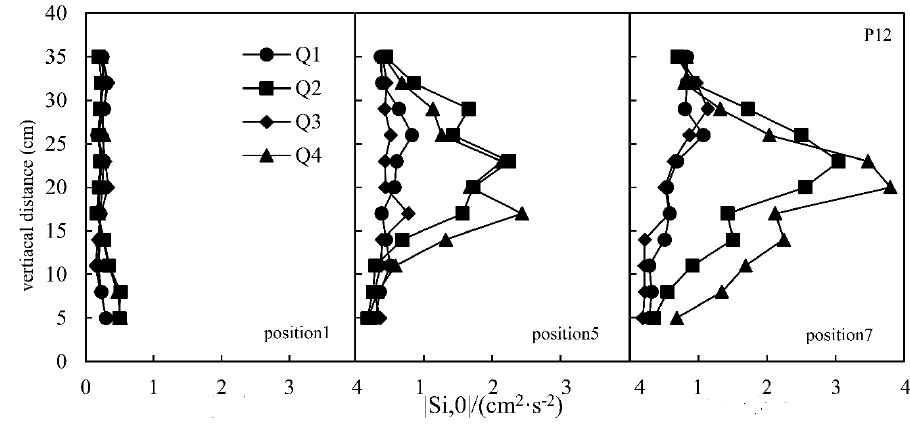
Figure 7. Reynold’s stress contribution values of the four quadrants.